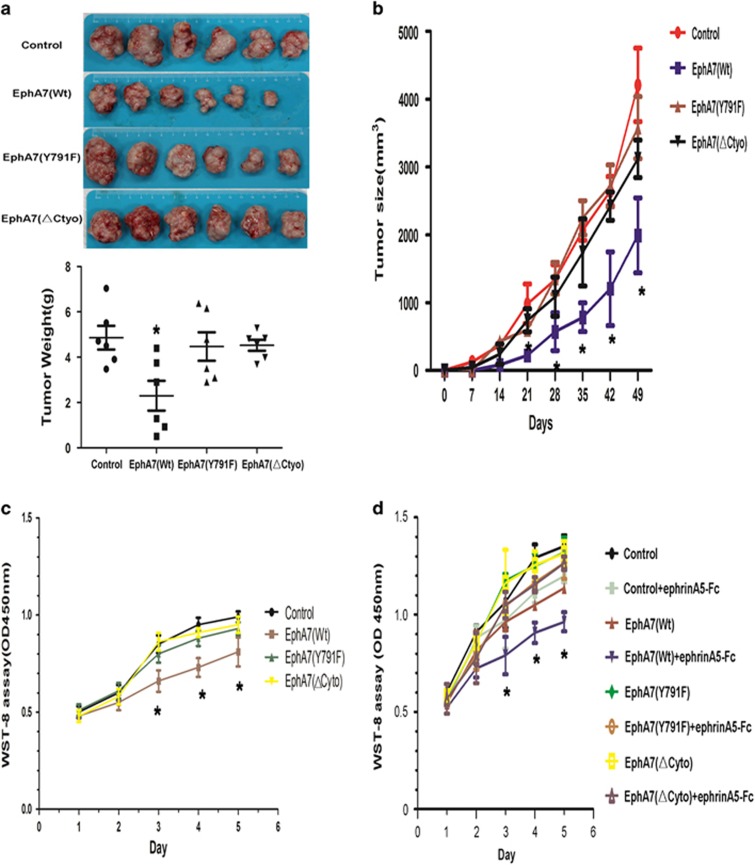
WT EphA7 inhibit tumor growth in vitro and in vivo. (a) Subcutaneous xenograft PCa models were generated using PC-3/Control, PC-3/EphA7(WT), PC-3/EphA7(KD), or PC-3/EphA7(ΔCyto) cells. After mice had been terminally narcotized and killed over 49 days, tumors were removed and the weights measured. The average horizontal lines represent the means in the groups. (b) Tumor growth was monitored over seven weeks, and the average tumor volumes of primary tumors were calculated (six mice per group). (c) The proliferation of DU145 cells stably overexpressing either EphA7(WT) receptor or EphA7 mutants was evaluated using a colorimetric WST-8 assay. (d) Proliferation of PC-3 cells overexpressing the EphA7(WT) receptor or EphA7 mutants. Cells were plated in 96-well plates and then serum-deprived for 24 h. After stimulation of 1.0 μg/ml of ephrinA5 ligand or Fc, cell viability from 24 h (To) and seven days (T7) in culture was determined using a colorimetric WST-8 assay. Data are shown as the mean±.S.D. *P<0.05, versus the respective control group